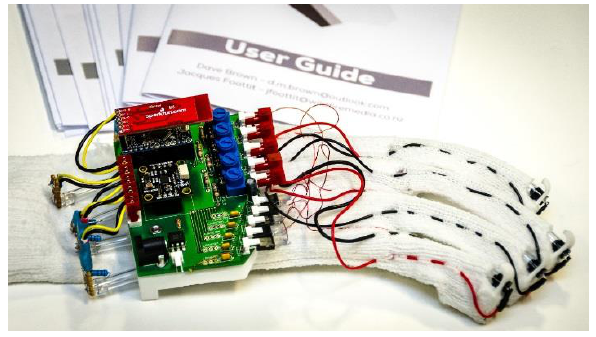
Figure 1. Initial glove